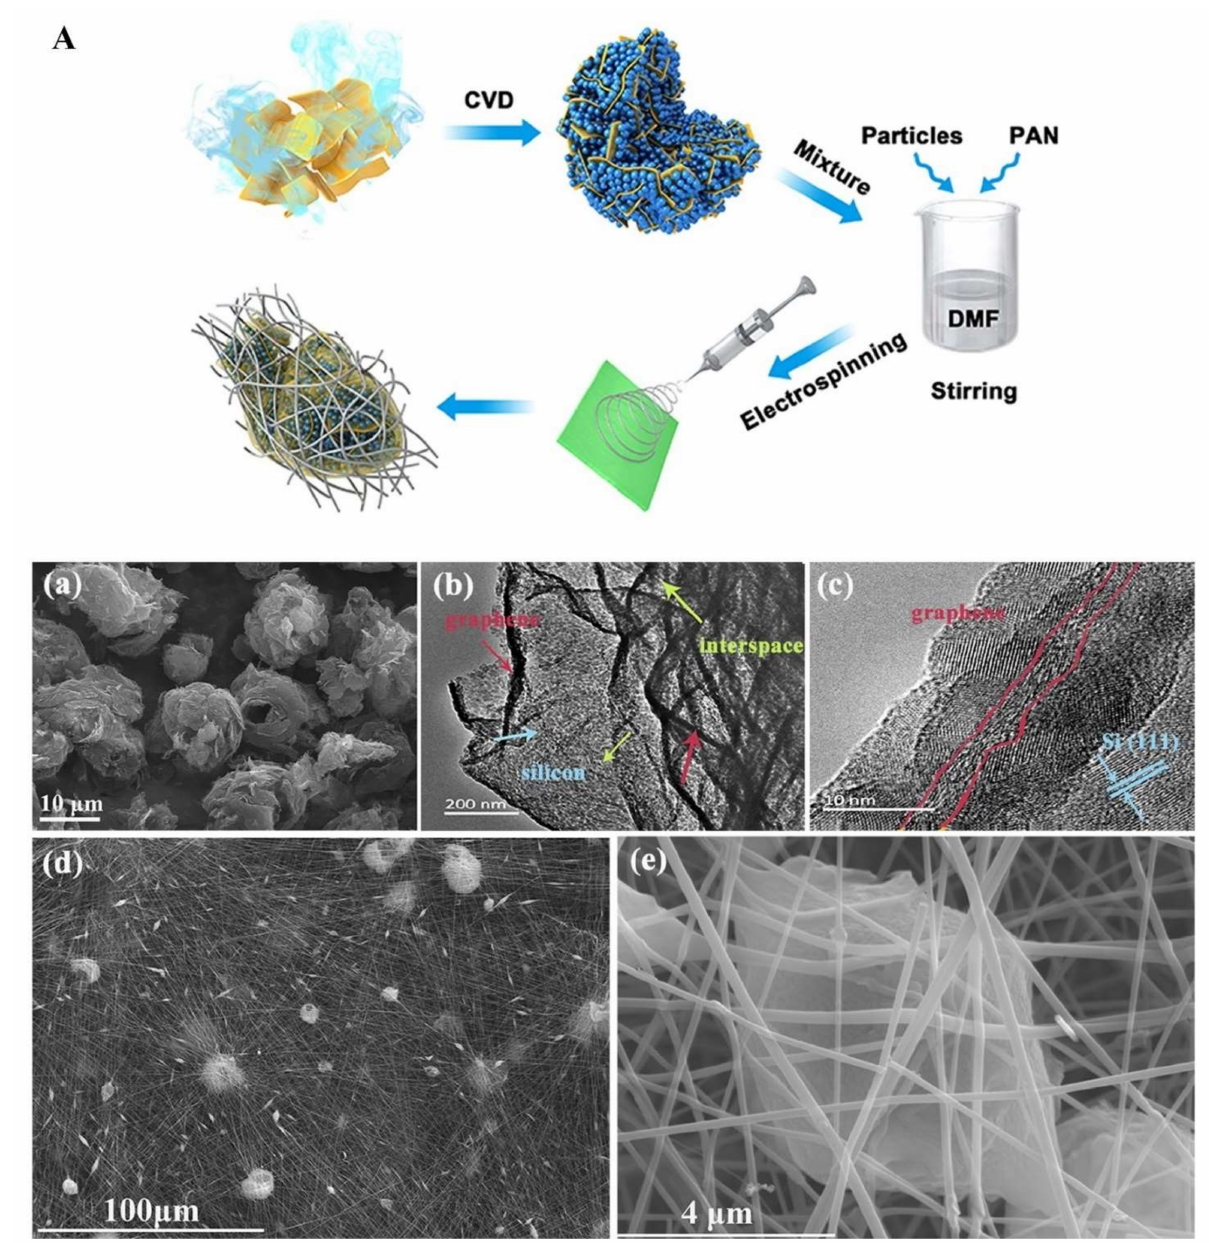
Figure 20. ( A ) Schematic illustration on the synthesis of process of the G/Si@CFs composites ( a ) SEM image of G/Si particles, ( b , c ) HRTEM image of G/Si particles, ( d ) low magnification SEM image of G/Si@CFs, and ( e ) high magnification SEM image of G/Si@CFs. Adapted and reproduced with permission from Ref. [92]. Copyright 2017